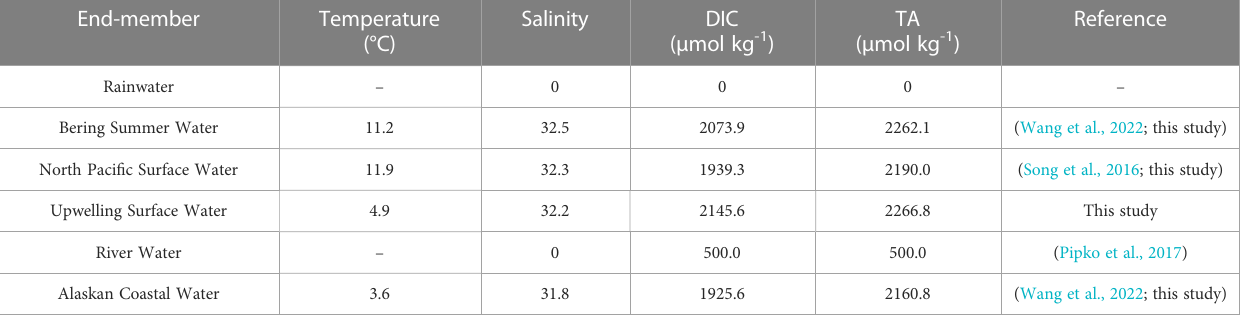
TABLE 2 Summary of end-member values used in the two end-member mixing models in different sub-regions of the Bering Sea.